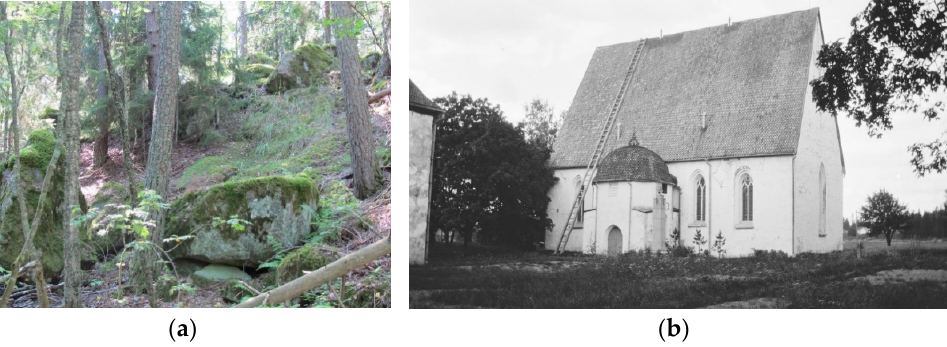
Figure 2. Views of the target area: ( a ) remains of the post office located by the border checkpoint between Sweden and Russia. Photo: Thomas Ermala on 28 August 2019; ( b ) Pyttis church from the latter half of the 1400s was situated in the Russian territory after the peace treaty of 1743. Photo: C. W. Stenbäck in 1932. Source: Picture collections of the Finnish Heritage Agency.